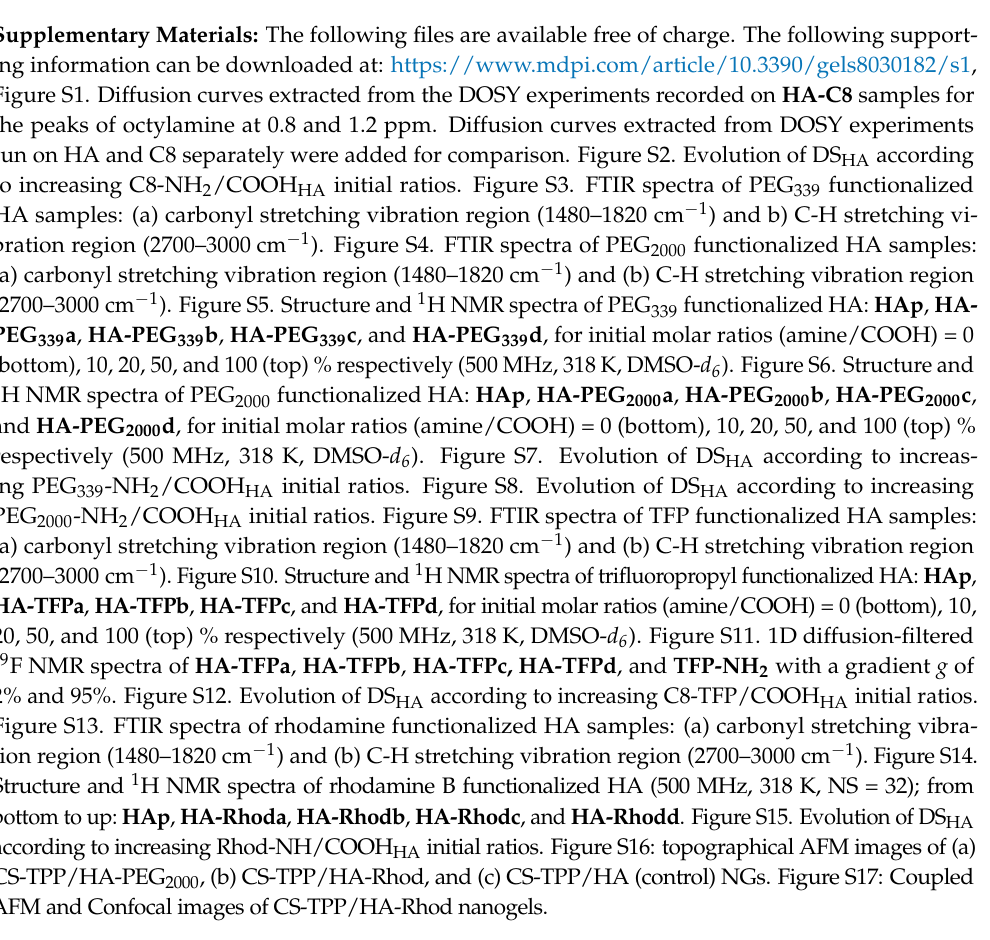
F NMR spectra of HA-TFPa , HA-TFPb , HA-TFPc, HA-TFPd , and TFP-NH 2 with a gradient g of 2% and 95%. Figure S12. Evolution of DS HA according to increasing C8-TFP/COOH HA initial ratios. Figure S13. FTIR spectra of rhodamine functionalized HA samples: (a) carbonyl stretching vibra- tion region (1480–1820 cm − 1 ) and (b) C-H stretching vibration region (2700–3000 cm − 1 ). Figure S14. Structure and 1 H NMR spectra of rhodamine B functionalized HA (500 MHz, 318 K, NS = 32); from bottom to up: HAp , HA-Rhoda , HA-Rhodb , HA-Rhodc , and HA-Rhodd . Figure S15. Evolution of DS HA according to increasing Rhod-NH/COOH HA initial ratios. Figure S16: topographical AFM images of (a) CS-TPP/HA-PEG 2000 , (b) CS-TPP/HA-Rhod, and (c) CS-TPP/HA (control) NGs. Figure S17: Coupled AFM and Confocal images of CS-TPP/HA-Rhod